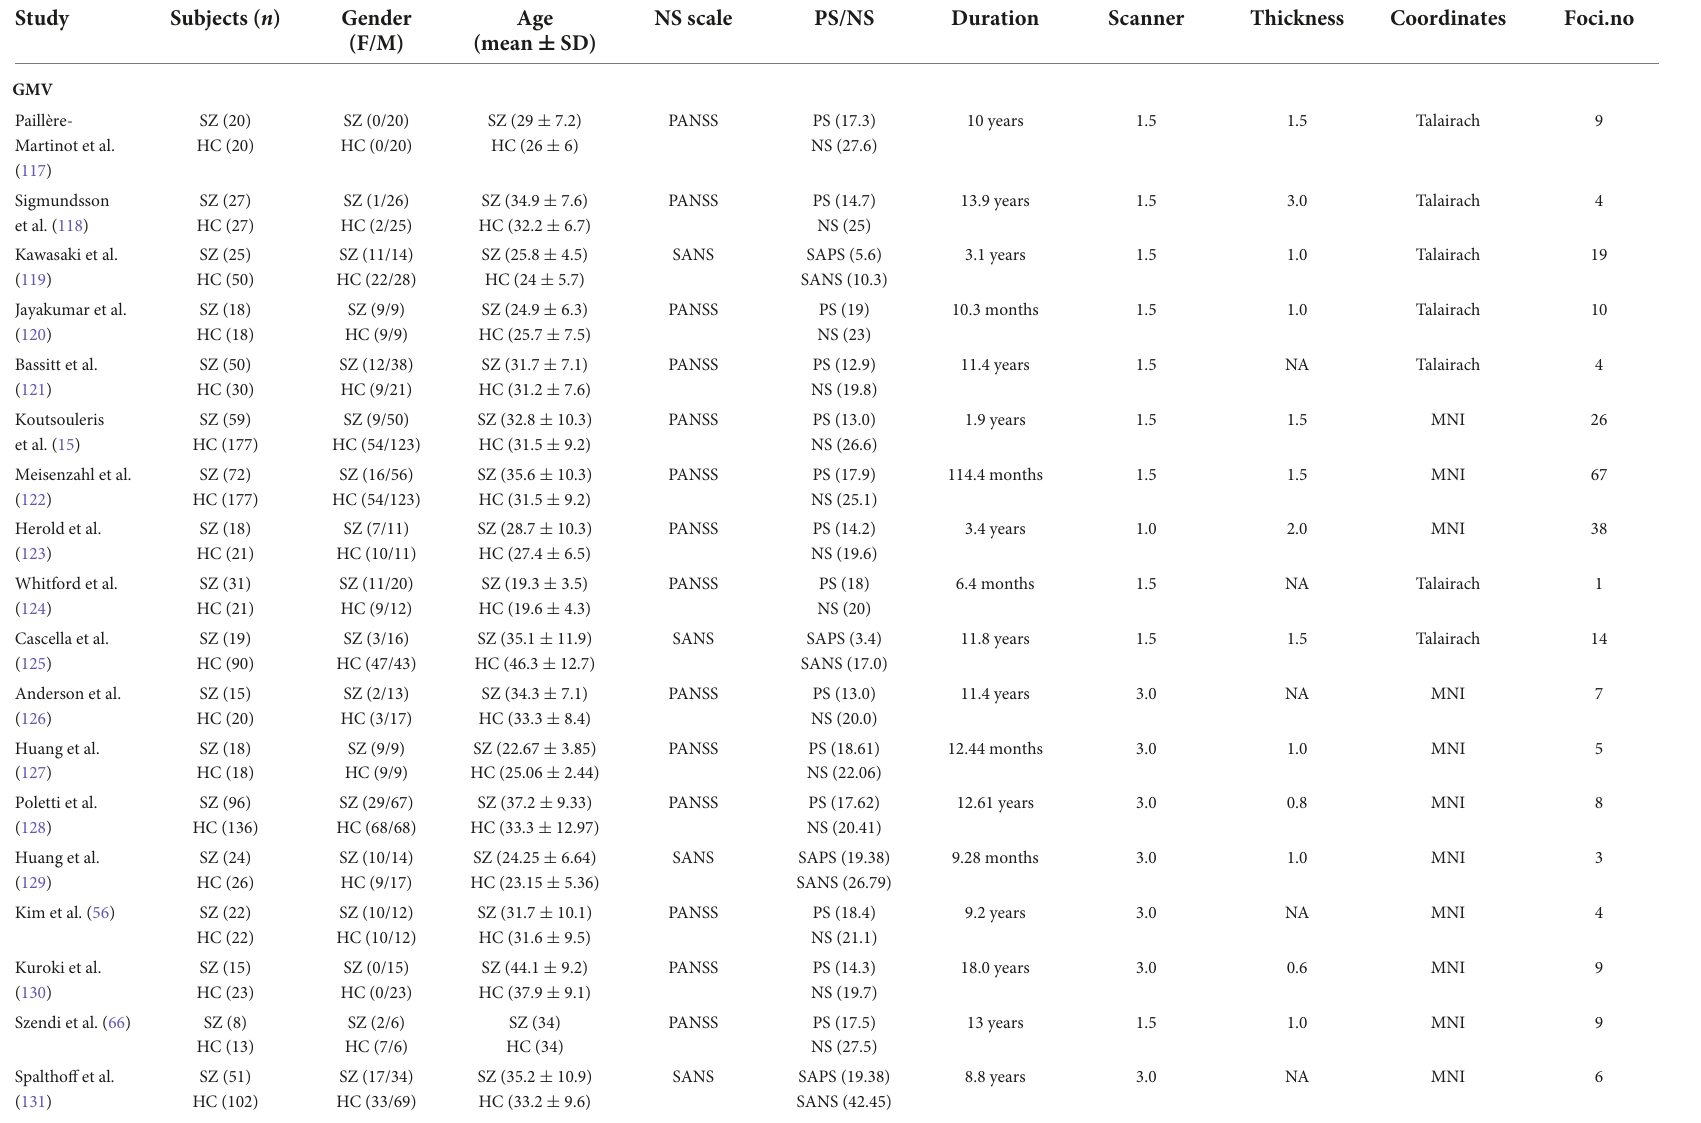
TABLE 1 Demographic and clinical information for the structural MRI studies included in the